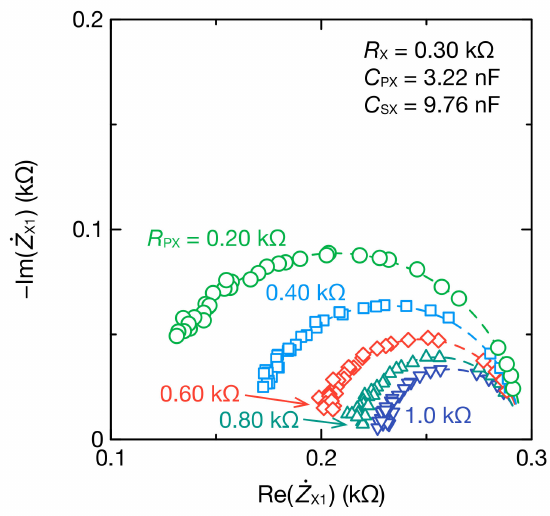
. Z X1 for the bioimpedance models with C PX = 3.22 nF and C SX = 9.76 nF. Figure 13. Cole–Cole plot of The dashed lines represent the fitting curves obtained from Equations (9) and